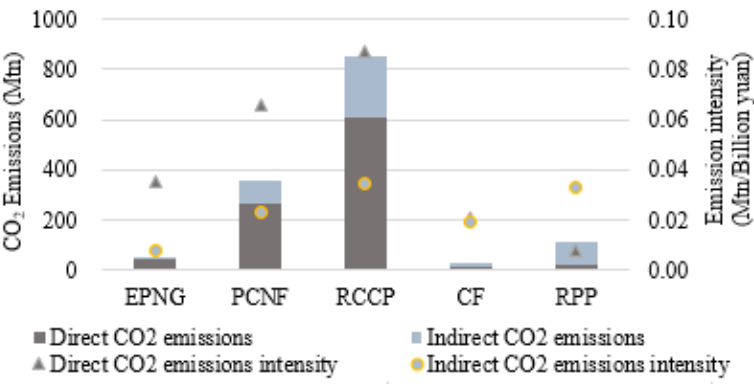
Figure 3. Direct and indirect CO 2 emissions and intensity of the petrochemical industry (2012) .